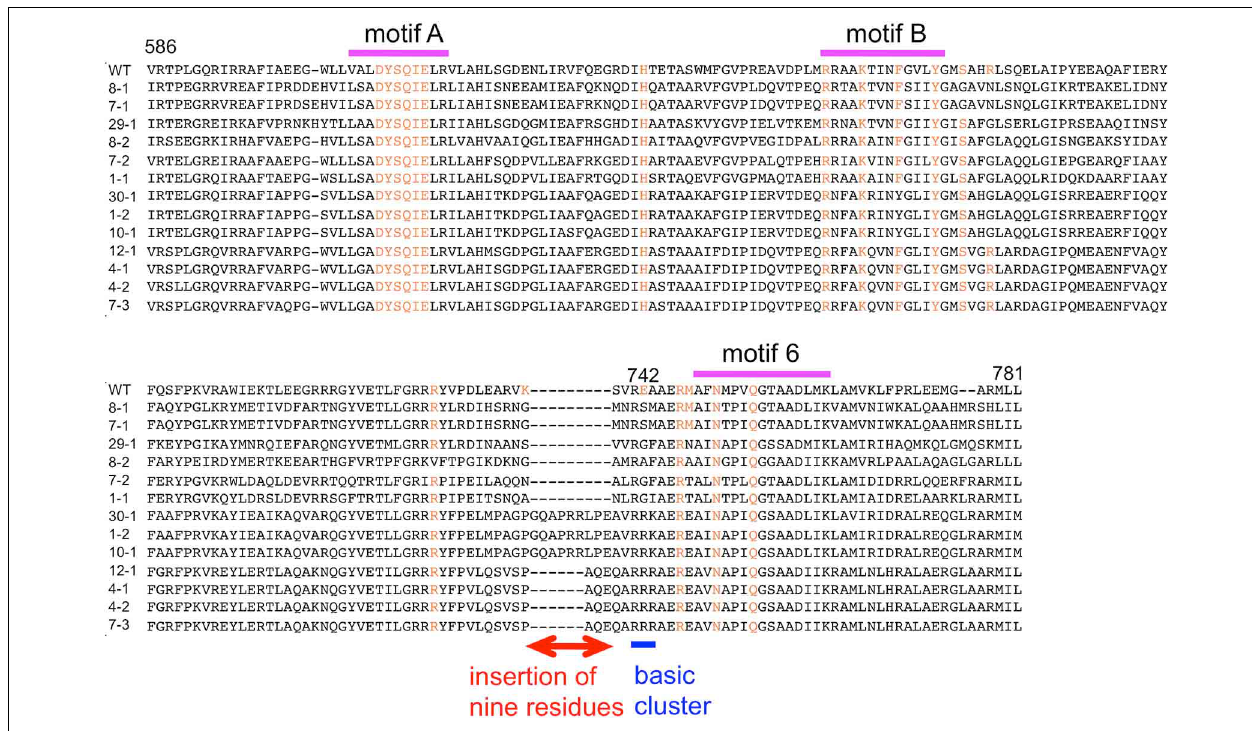
FIGURE 3 | Alignment of the amino acid sequences of chimeric Taq polymerases with extension rates over 1kb/min. A multiple alignment of the amino acid sequences of the substituted regions in the chimeric Taq polymerases with higher extension rates. The conserved motifs are shown on the top (Loh and Loeb, 2005). The